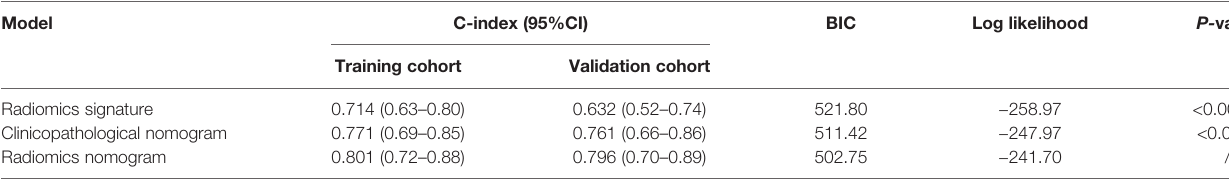
TABLE 4 | Performance of models.